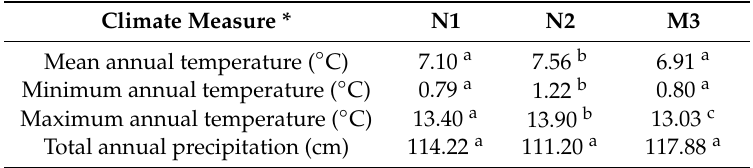
Table A1. Average climate conditions by site, measured on an annual basis from